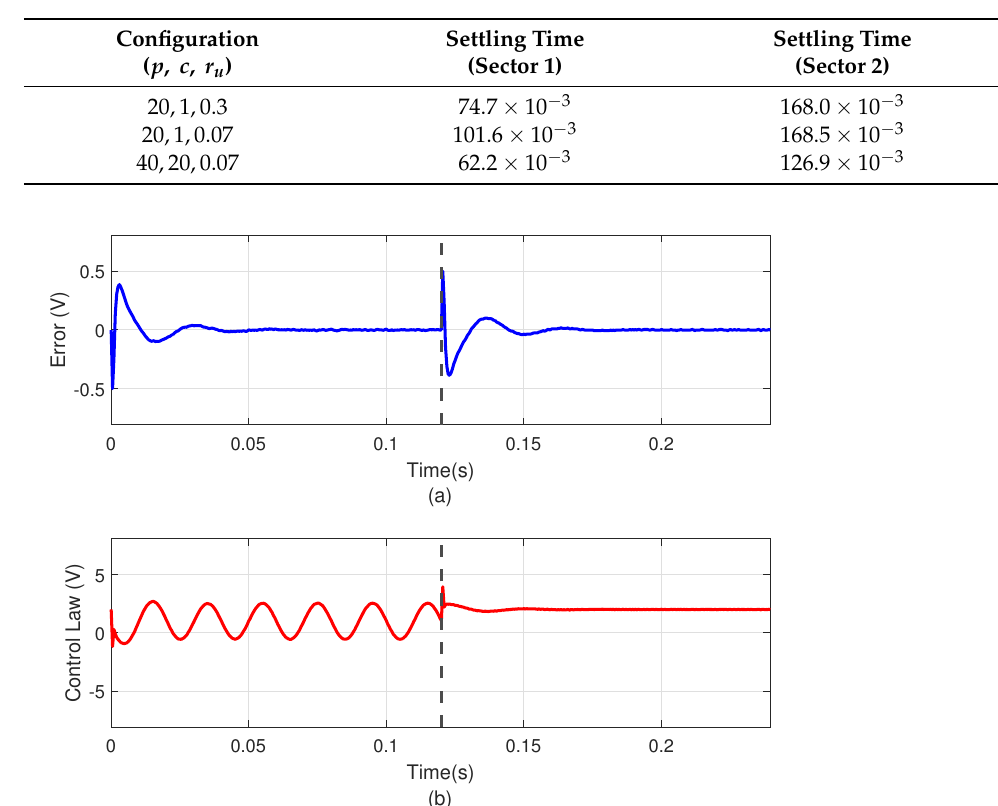
Table 4. Settling Time for Test 2.